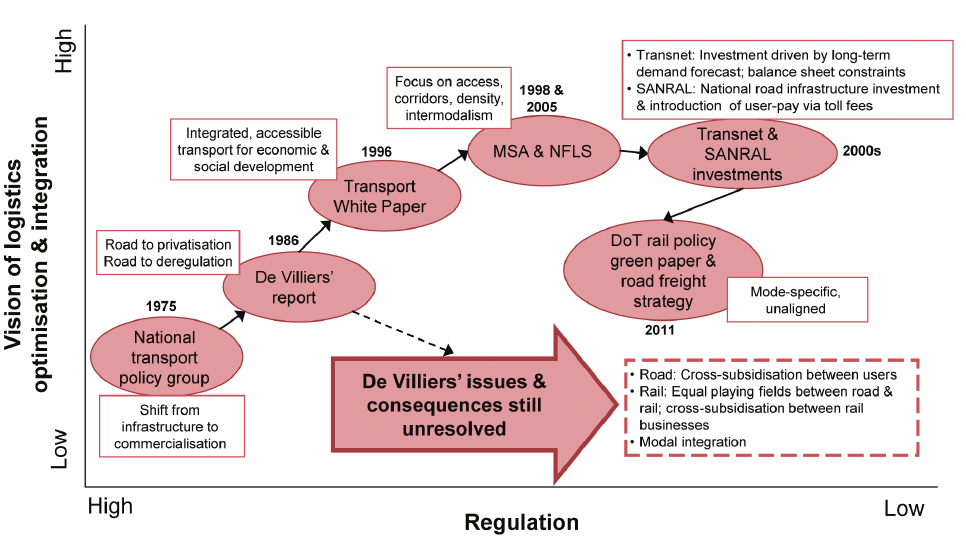
Figure 3: Evolution of South Africa’s freight transport